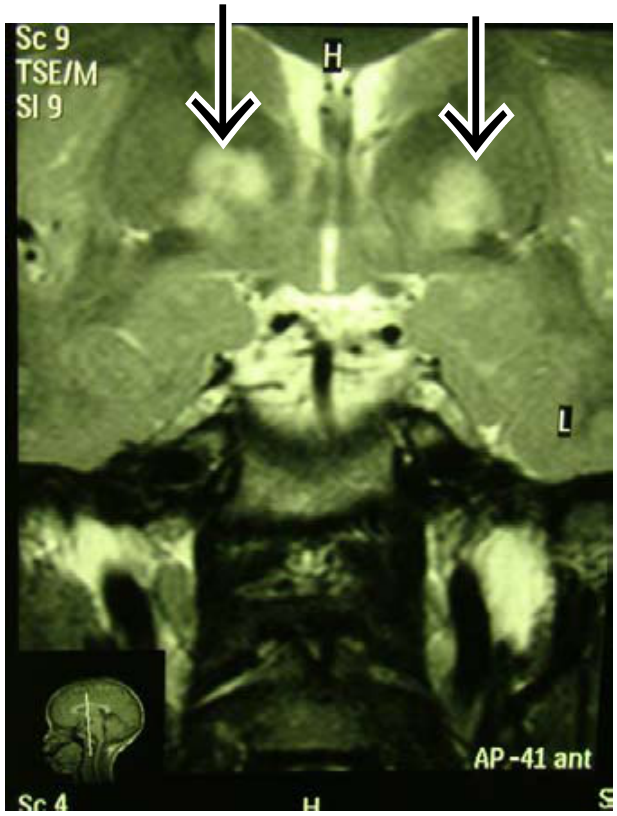
Fig. 6c. Coronal T2-weighted MRI of the same patient. Note that these lesions are hyperintense with fairly well-defined margins and no mass effect.